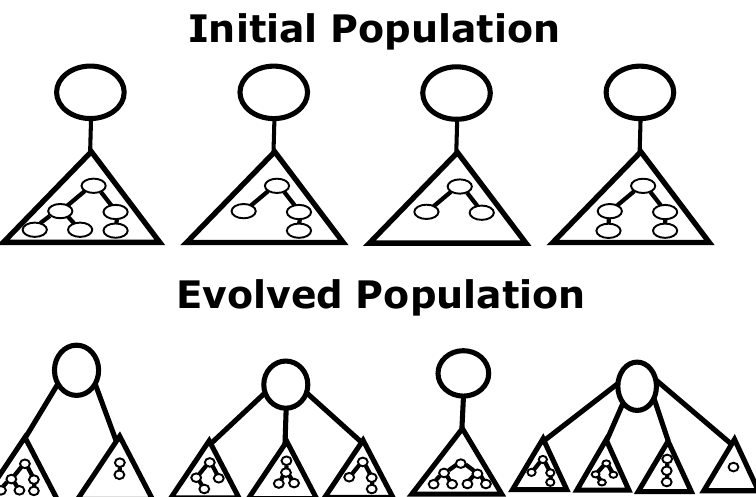
Figure 4. An example of a transformation produced by M3GP for a problem with three classes. On the left are the original data with a low classification accuracy Figure 4a. On the right are the same data transformed into a space where the resulting classifica- tion achieves a very good accuracy Figure 4b. The large circles represent the centroids of each class and each data point is marked by a different symbol depending on the class (i.e., dot, cross, small circle).